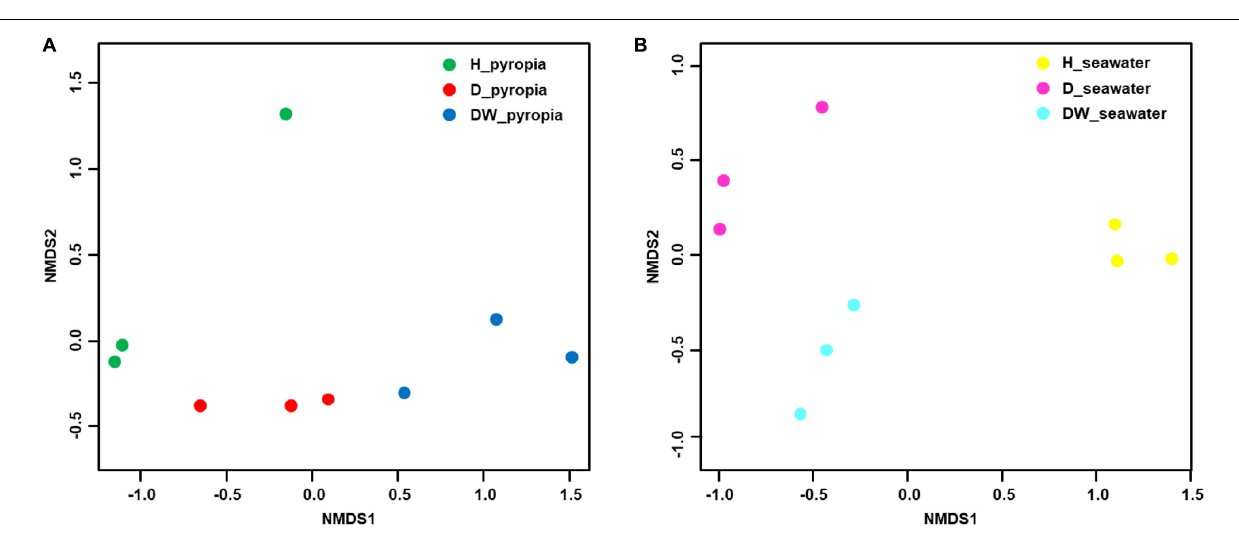
OTU5 ( Marivita ), OTU9 (SAR11 clade Ia), and OTU7 ( Planktomarina ) in Alphaproteobacteria, OTU2 (SAR92